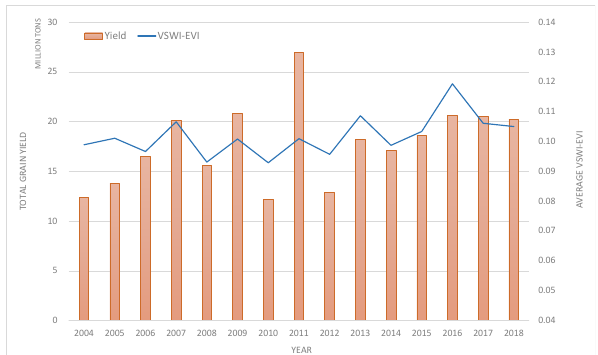
Figure 4. Annual variation of total grain yield and remote sensing drought index (mean VSWI-EVI) from 2004 to